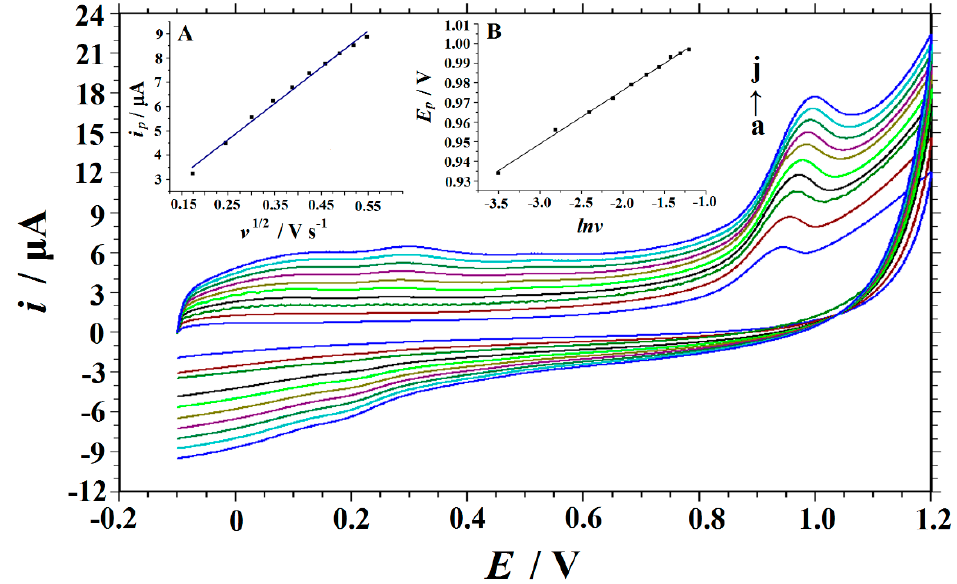
Figure 5. Cyclic voltammograms of 10 μ M of RhB in a 0.15 M HAc–NaAc buffer (pH 6.6) obtained on the Cu 2 O NPs ‒ ERGO/GCE at different scan rates ( a – j : 0.03, 0.06, 0.09, 0.12, 0.15, 0.18, 0.21, 0.24, 0.27, AND 0.3 V·s − 1 ). Inset: ( A ) The plot of the peak current versus scan rate; ( B ) the plot of the peak potential versus the Napierian logarithm of scan rate.